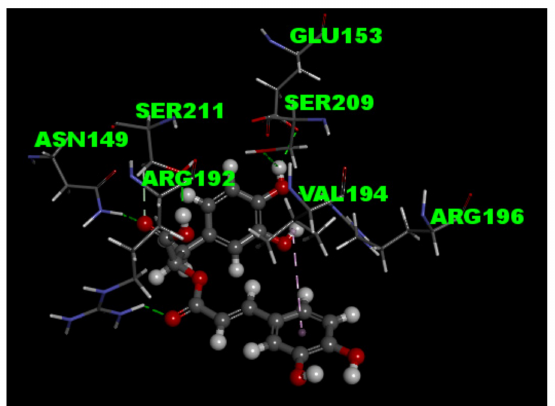
Figure 6. Prediction of the interaction of rosmarinic acid to GABA A receptor protein using molecular docking. Molecular docking modeling of rosmarinic acid with the active site of molecular structure of GABA A receptor protein (PDB ID 4COF) was performed using the Discovery Studio 4.1 software (BIOVIA software Inc., San Diego, CA, USA). Protein–ligand hydrogen-bonding interactions are displayed as green